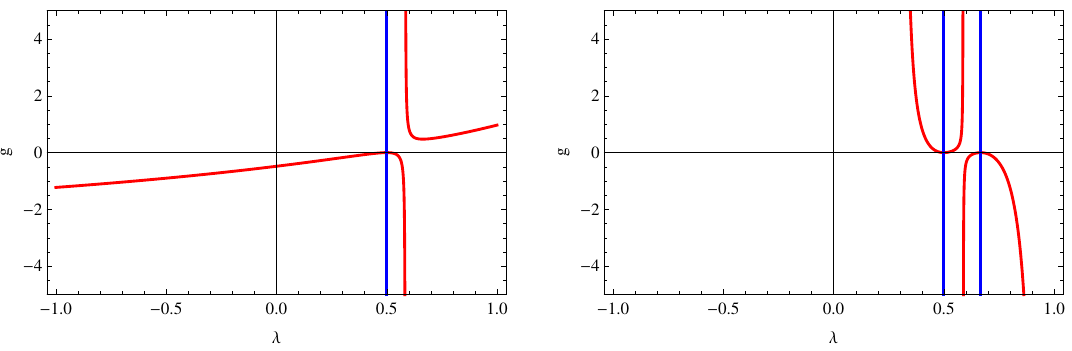
Figure 1 . Singularity structure of the beta functions (3.23) in the (cid:21) - g -plane in d = 2 (left diagram) and d = 3 (right diagram). The blue lines indicate (cid:12)xed singularities of (cid:12) (cid:21) , eq. (4.4), while the red lines illustrate the curves (4.5) and where (cid:17) develops a